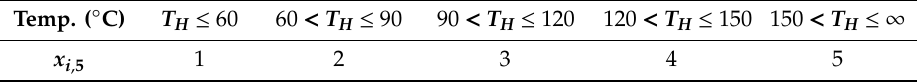
Table 5. Performance values x i ,5 for 5th